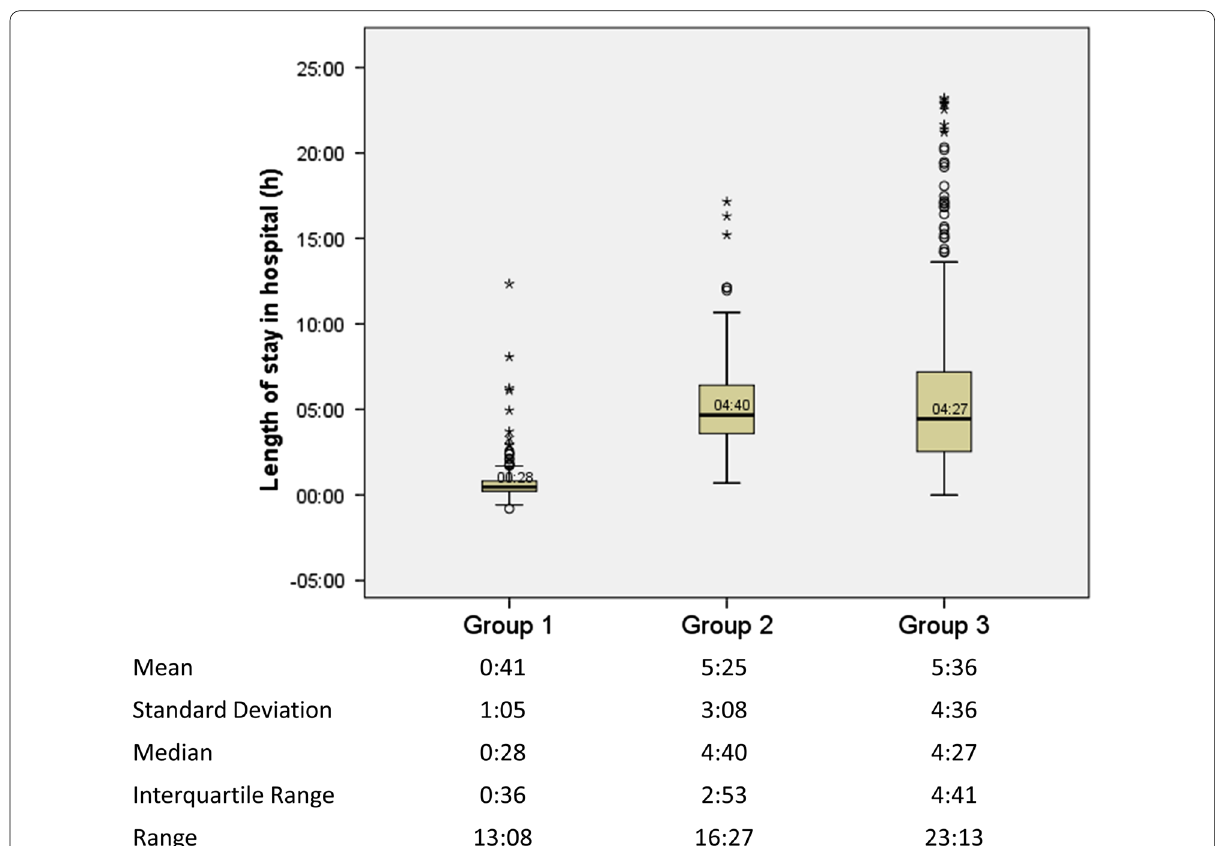
Fig. 3 Process length in the 3 clinical groups. Time span was longer and dispersion higher when patients arrived to the emergency department (ED) by themselves (group 3) or when referred to the ED from the primary care high-resolution radiology service (pcHRRS) (group 2) than pcHRRS patients discharged with normal X-rays (group 1). Box upper and lower edges correspond to quartiles 3 (Q3) and 1 (Q1), respectively; ends of the whiskers represent